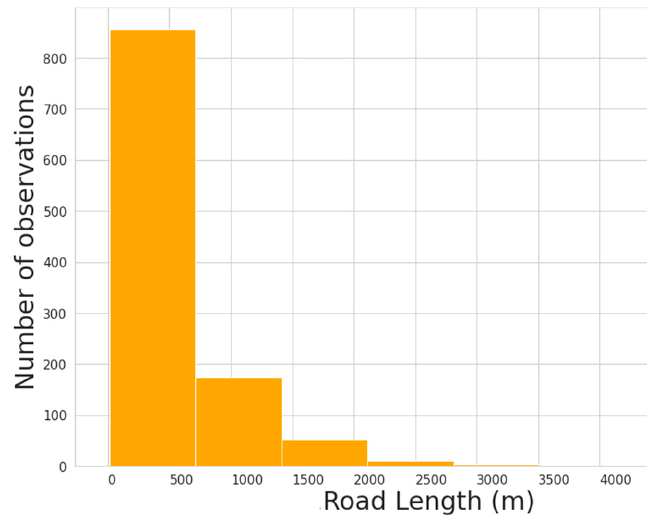
Figure 5. Distribution of feature—Road Length.